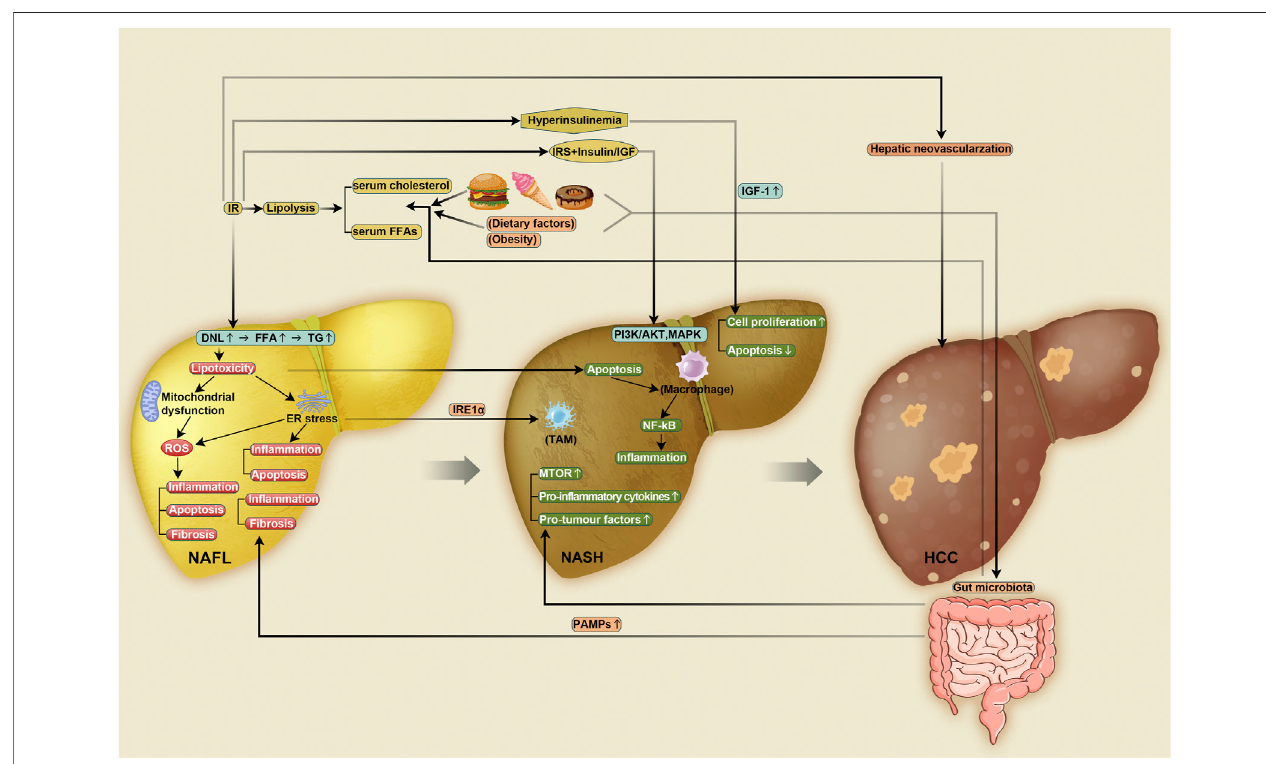
FIGURE 1 | Proposed mechanism of NASH and NASH-driven HCC. Insulin resistance causes a compensatory increase in insulin in the body, leading to hyperinsulinemiaandamarkedincreaseinIGF-1levels.Theseconditionscanpromotehepatocyteproliferationandinhibitapoptosis.Therefore,theycanexacerbatethe development of HCC. Insulin resistance also directly triggers HCC by promoting hepatic neovascularization. When insulin resistance occurs, IRS binds to insulin or IGF and induces HCC through the PI3K/Akt and MAPK pathways. Insulin resistance promotes lipolysis in adipose tissue, which leads to increased serum cholesterol and FFA levels. High levels of FFA in the serum travel to the liver, causing asigni fi cant increase in FFA in the liver. Insulin resistance can also directly promote DNL, which leads to an increase in hepatic FFA levels. Increased FFA levels in the liver promotes the synthesis of TG and triggers lipotoxicity. Lipotoxicity induces apoptosis, which activates liver macrophages and triggers in fl ammation through the NF-kB pathway, further inducing the development of HCC. Lipotoxicity also leads to mitochondrial dysfunction and ER stress, both of which further induce ROS production. This further promotes in fl ammation, apoptosis and fi brosis, thereby contributing to the developmentofNASH and NASH-HCC.ERstresscanalso directly promote in fl ammationand apoptosis. Dietary factors, obesityand thegutmicrobiota also contribute to elevated serum cholesterol and FFA levels, and diet and obesity alter the gut microbiota. The gut microbiota promotes in fl ammation and fi brosis through PAMPs, whichfurtherinduce NASHand NASH-HCC.Changesinthegutmicrobiota canalso directlytrigger HCCthrough elevated levelsofMTOR,proin fl ammatoryfactorsand protumor factors. IGF: insulin-like growth factor, HCC: hepatocellular carcinoma, PI3K: phosphatidylinositol 3-kinase, Akt: protein kinase B, MAPK: mitogen-activated protein kinase, FFA: free fatty acid, DNL: de novo lipogenesis, TG: triglyceride, NF-kB: nuclear factor-jB kinase-b, ER: endoplasmic reticulum, ROS: reactive oxygen species, NASH: nonalcoholic steatohepatitis, PAMPs: pathogen-associated molecular patterns, MTOR: mammalian target of rapamycin.